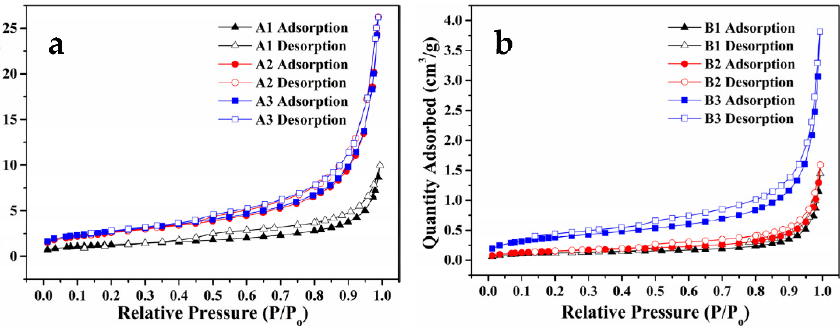
Figure 4. LT-N 2 A isotherms of the mudstone ( a ) and coal ( b ) specimens with distinct granule diameters. Table 2. BJH pore structural parameters of the mudstone and coal specimens with distinct granule diameters from the LT-N 2 A measurement.